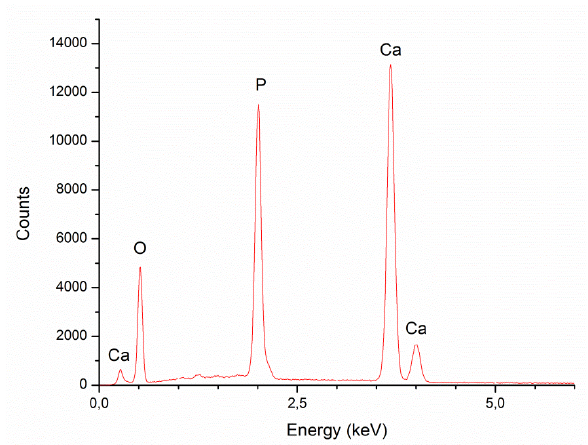
Figure 8. Energy-dispersive X-ray spectroscopy (EDX) spectra for HAp used for modifications of PUR scaffolds.